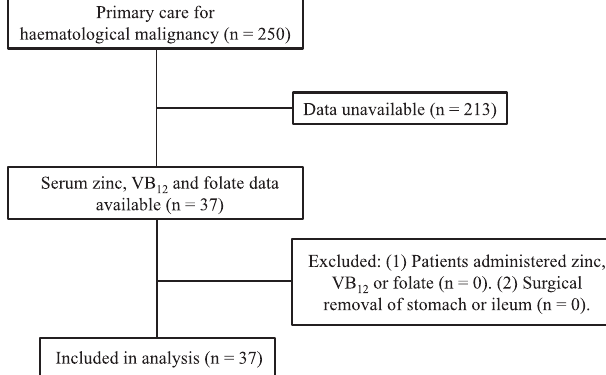
Figure 1 Study flow chart. VB 12 : vitamin B 12